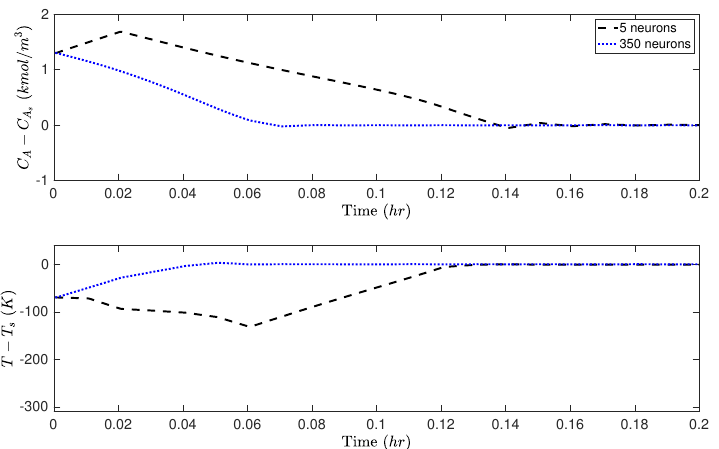
Figure 16. Closed-loop state profiles under LMPC using two RNN models trained with differ- ent widths.